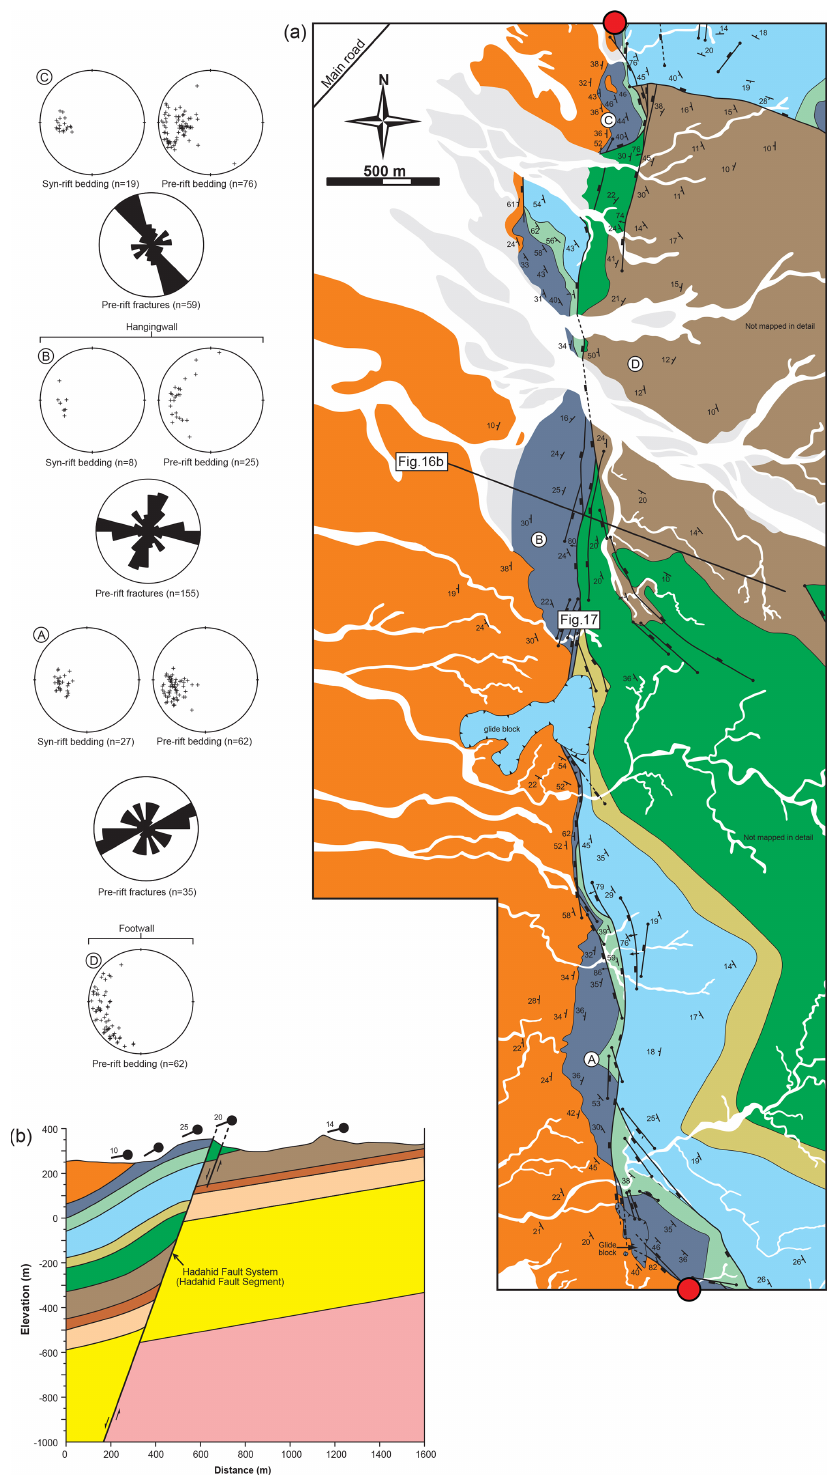
Figure 16. (a) Field map of the Hadahid Fault Segment of the Hadahid Fault System. Colour key to stratigraphic units is shown in Fig. 3a. Red dots indicate the approximate boundaries between the identified segments. Lower-hemisphere projection stereonets summarize the dip and dip direction of pre- and syn-rift bedding ( a–g ; location shown on map). Rose diagrams show the trend of fractures in pre-rift strata. The location of the photograph shown in Fig. 17 and the cross sections shown in (b) are indicated. (b) Down-plunge cross section across the central part of the Hadahid Fault